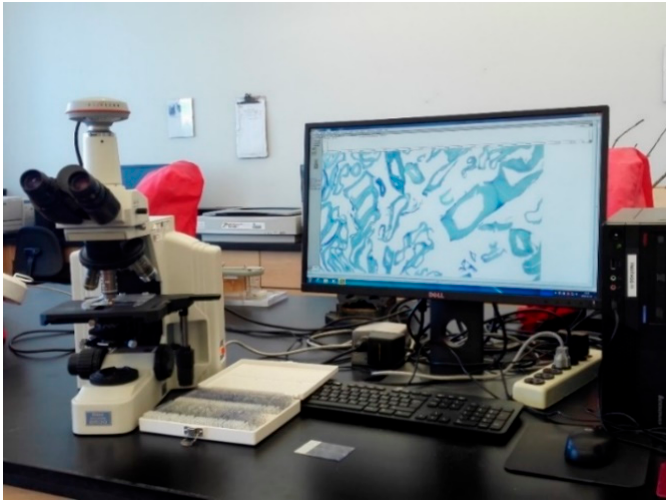
Figure 5. Setup used to measure mat porosity by image analysis: Optical microscope, camera, and Wincell software.